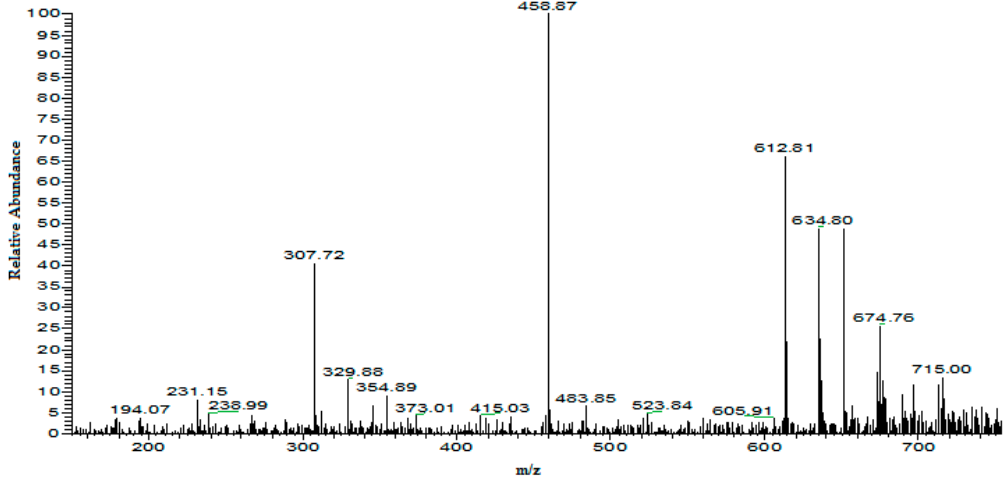
Figure 16. Mass spectra as obtained from the microfluidic device at the optimized potential of 0.37 V.